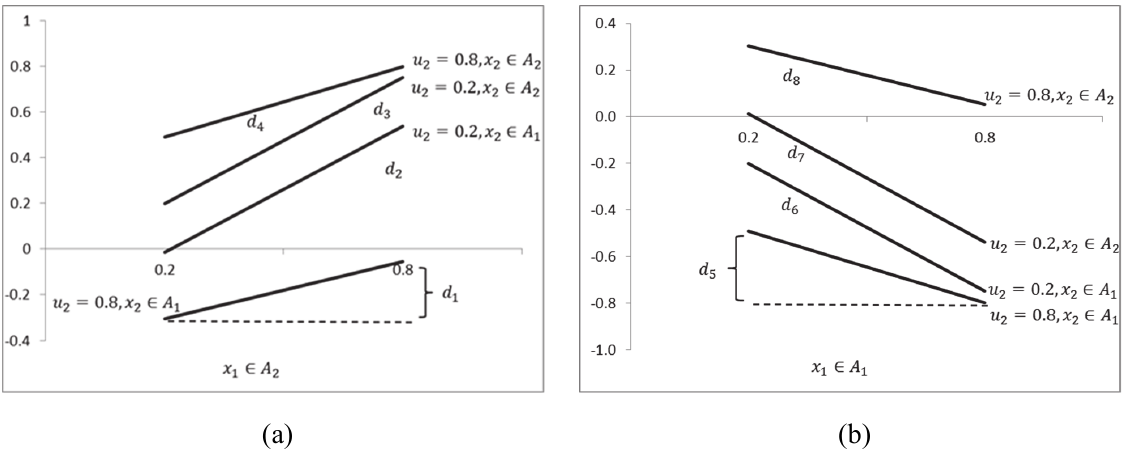
Fig. 6. Preference structure for Example 1. (a) Levels of criterion 1 belong to region A 2 . (b) Levels of criterion 1 belong to region A 1